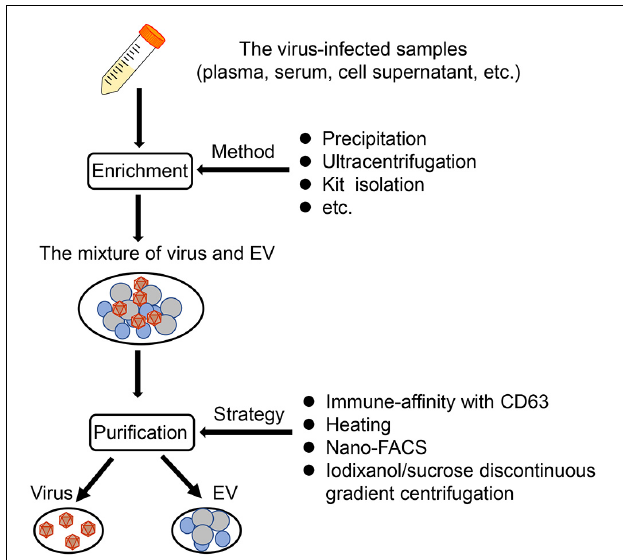
FIGURE 1 | The EV isolation from virus-infected samples. Based on published literature, a synthetic scheme to isolate EVs from virus-infected samples (such as plasma, serum, cell supernatant) is shown here. Generally, there are two steps, namely, enrichment, and purification. First, the mixture of virus and EVs can be obtained through several methods, such as precipitation, ultracentrifugation, and kit isolation. Then, the mixture is purified by applying mainly four strategies, immune-affinity with CD63, heating, nano-FACS, and iodixanol/sucrose discontinuous gradient